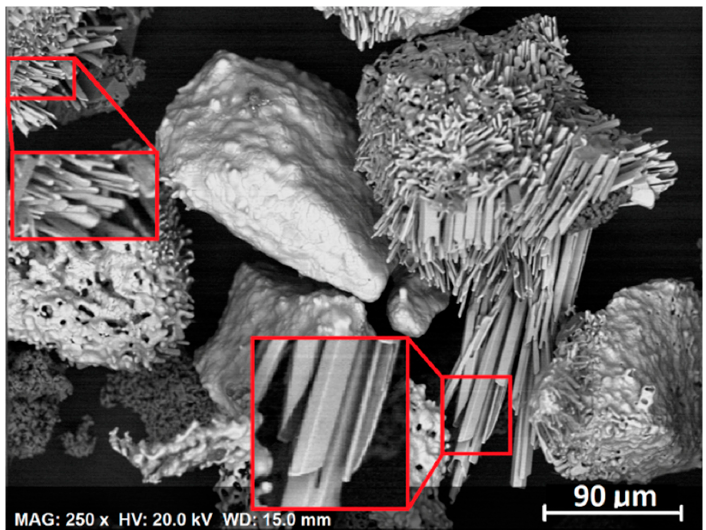
Figure 9. Ferrochrome alloy particles produced from the reduction of pellets containing 37–75 µm chromite, demonstrating the presence of monocrystalline ferrochrome carbide whiskers that had formed on the alloy surface.